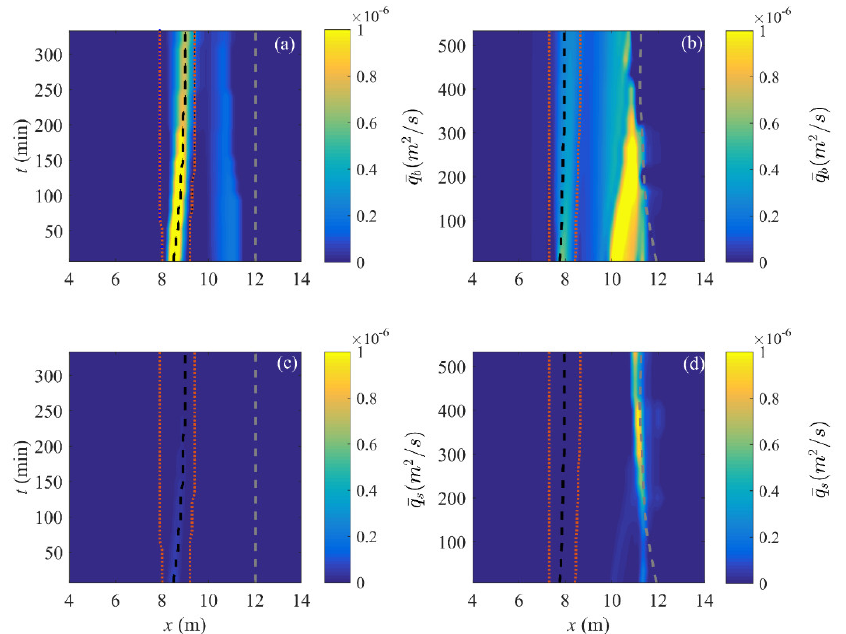
Figure 11. Spatiotemporal evolution of period-averaged bedload transport ( a , b ), and suspended sediment transport ( c , d ). Left panel is in case A1_2, and right panel is in case E1_1. Black dashed line means the crest of the nourishment and two dotted lines indicate two boundaries. Shoreline position is indicted by the grey dashed line.